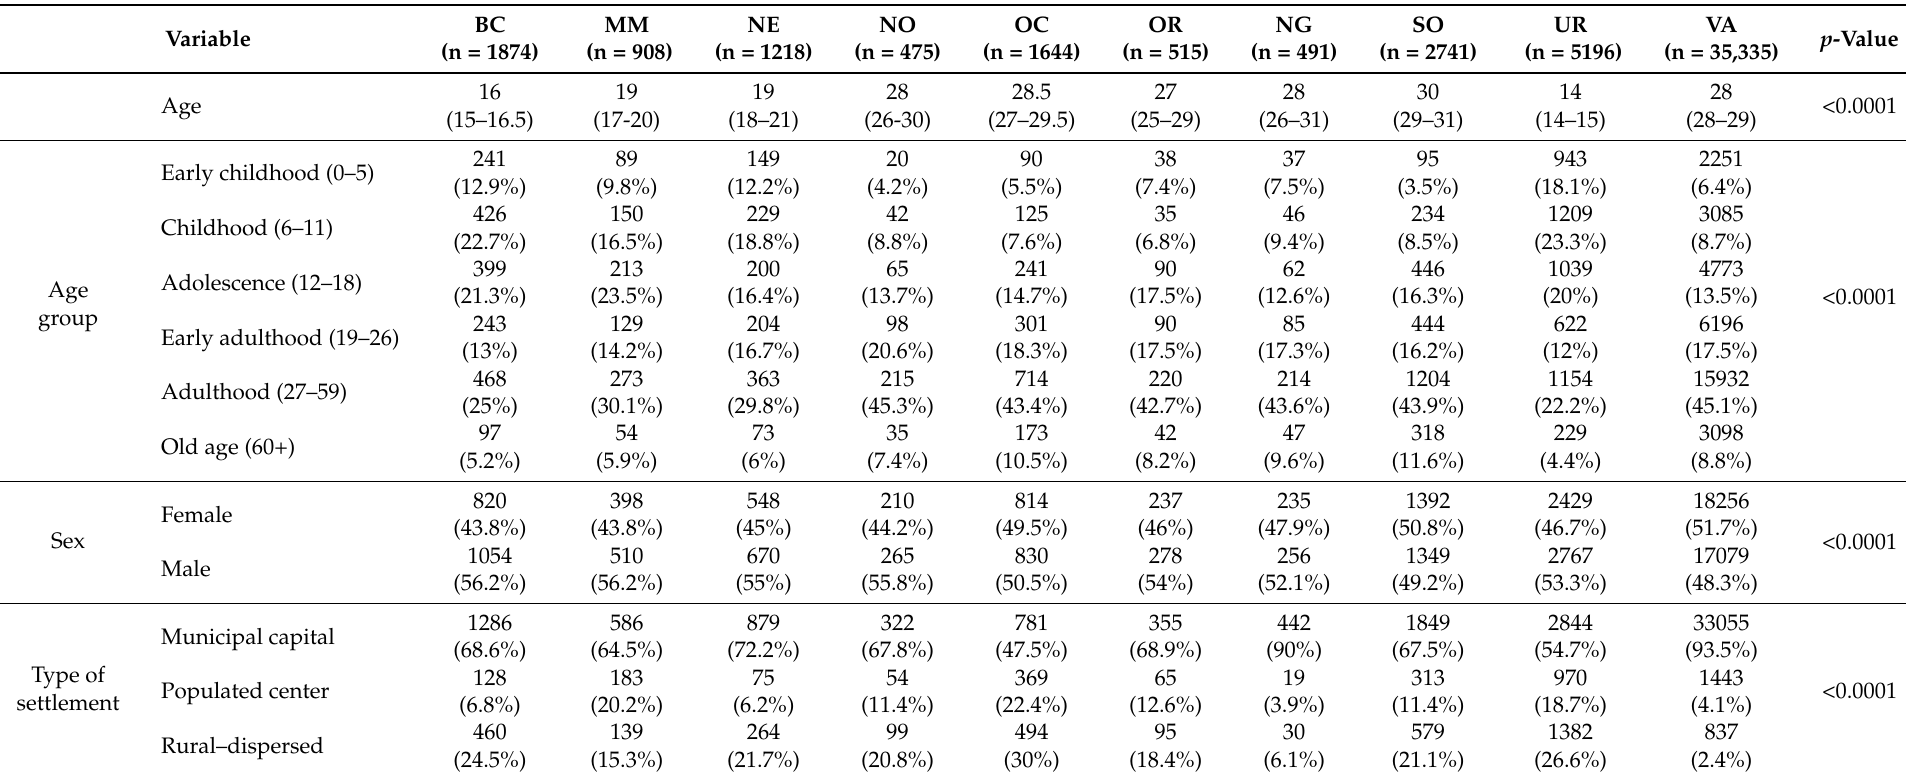
Table 4. Socio-demographic characteristics among patients, according to the